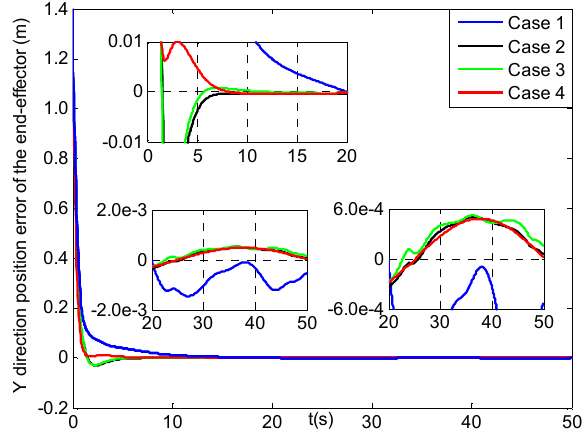
Figure 12. X direction position errors of the end − effector (four cases). Figure 14. Z direction position errors of the end − effector (four cases). Figure 14. Z direction position errors of the end − effector (four cases).